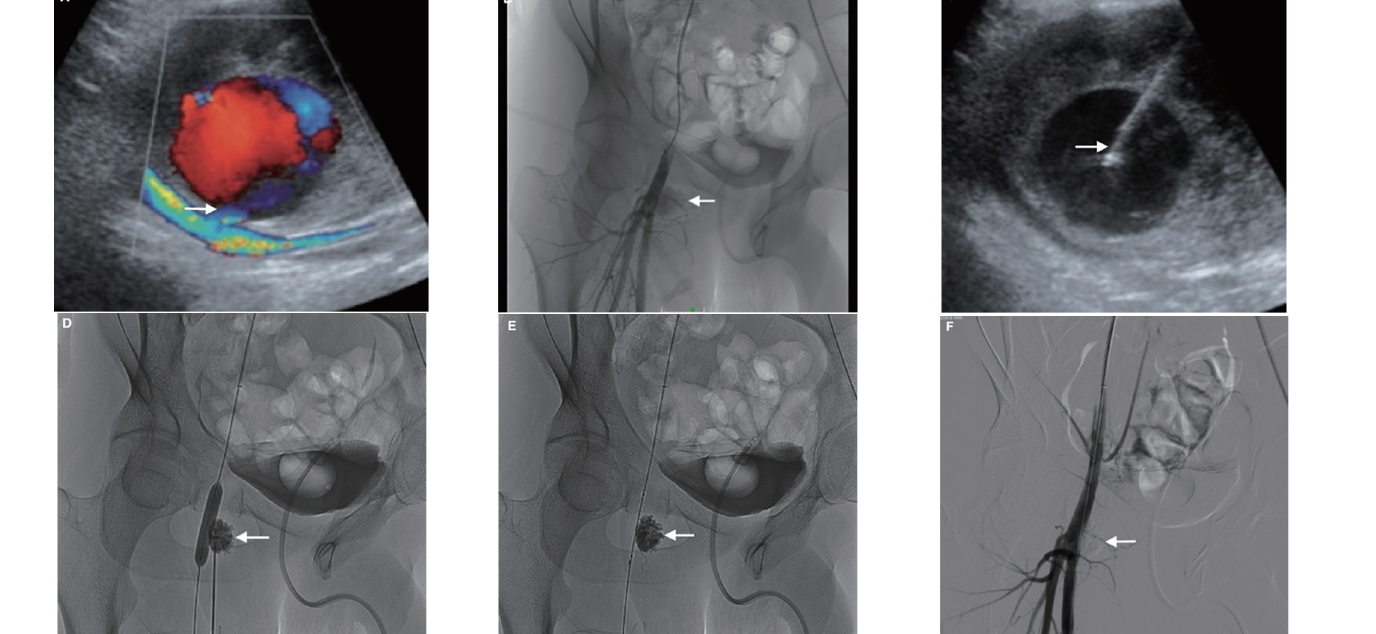
Figure 10. Example of a 62-year-old patient who developed a painful pulsatile mass with groin hematoma following coronary angioplasty. ( A ) Duplex ultrasound (US) at the groin puncture site demonstrated a large false aneurysm (FA) arising from the right proximal superficial femoral artery. ( B ) Angiography by crossover from the left side confirmed the FA from the superficial femoral artery (arrow). ( C ) The FA sac was then punctured under US guidance with a metallic needle with hyperechoic tip (arrow). ( D ) After inflating a Mustang TM balloon of appropriate size in the parent artery in front of the FA neck in order to avoid reflux, a Glubran ® 2/lipiodol of a ratio of 1:1 was injected into the FA sac under fluoroscopic guidance until complete filling of the FA (arrow). ( E ) Arteriogram after deflating the balloon demonstrated, few minutes after glue injection, no NBCA migration (arrow). ( F ) Final angiography after embolization showed complete occlusion of the FA (arrow) and confirmed patency of the parent